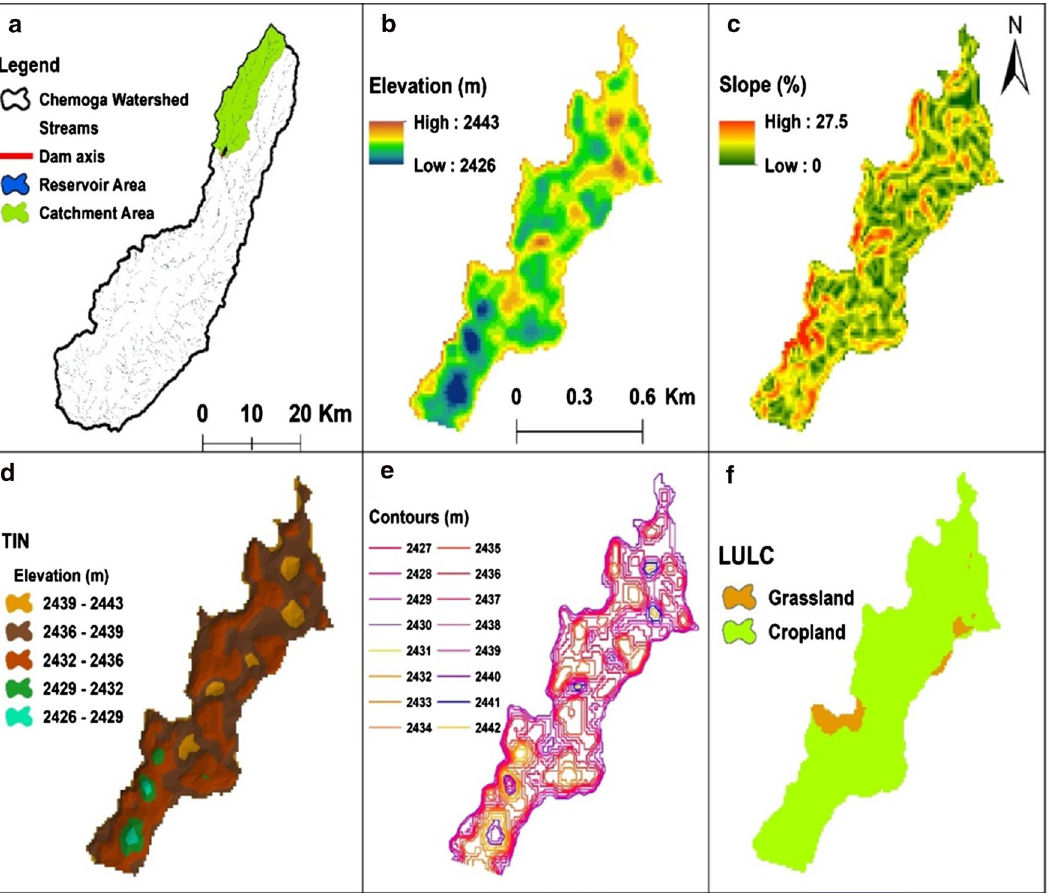
Fig. 12 Evaluation parameters for proposed Dam site 1: a Catchment area b DEM c slope d triangulated irregular network (TIN), e contours, f